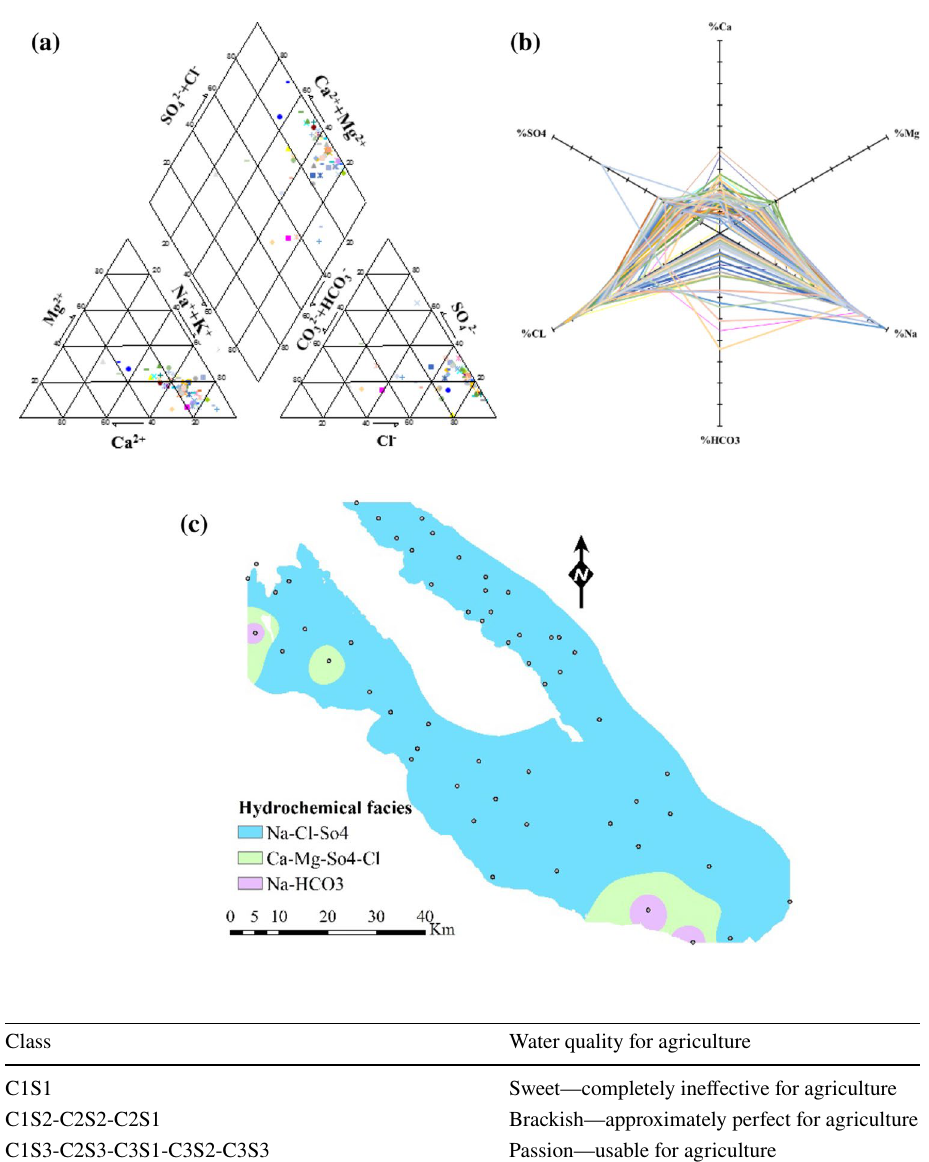
agricultural uses according to US Salinity classification (US Salinity Laboratory (USSL) 1954, Alavi, Zaree et al.